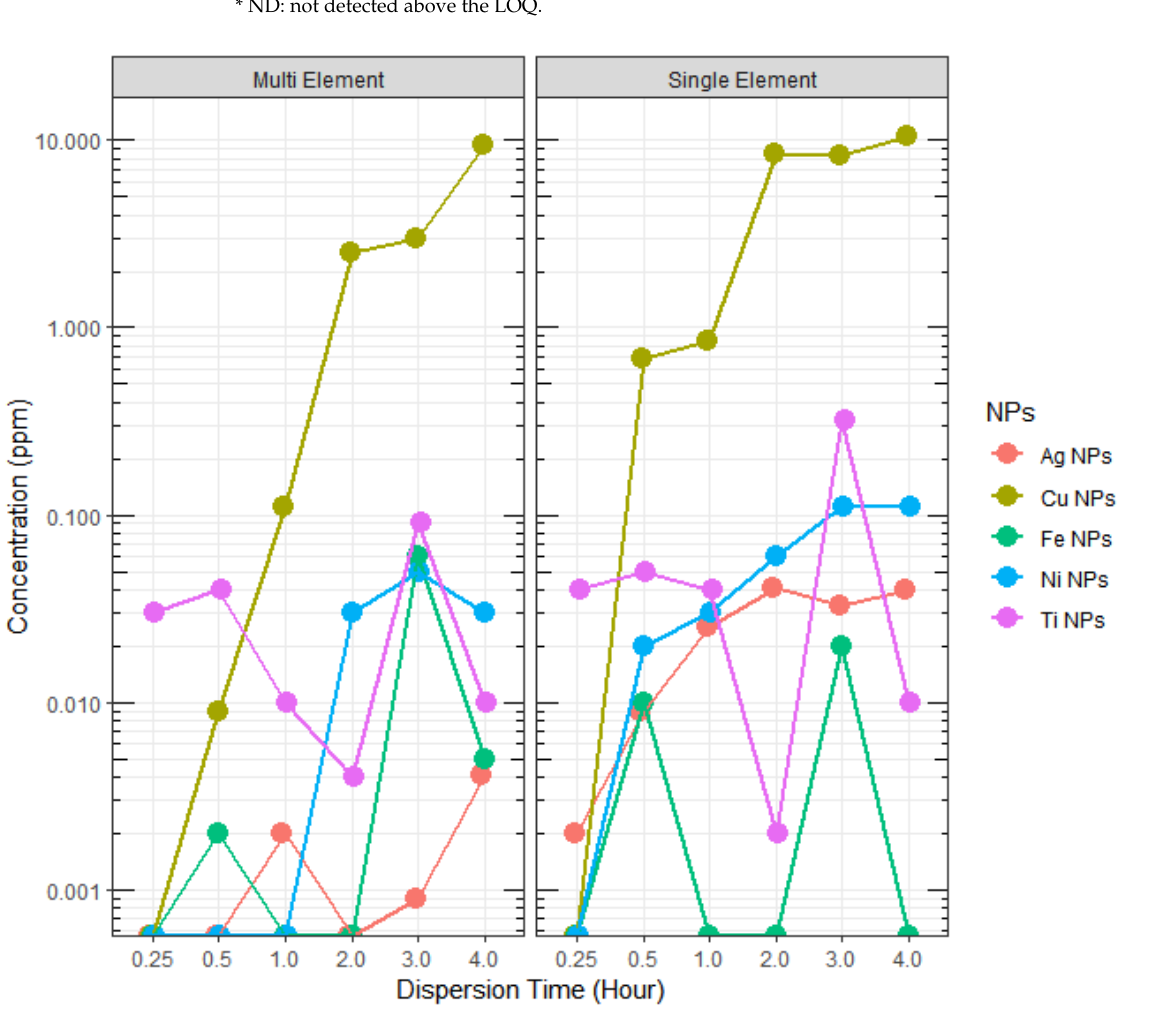
Figure 5. ICP-AES detected concentrations of MNPs in dispersion solutions at various dispersion times.